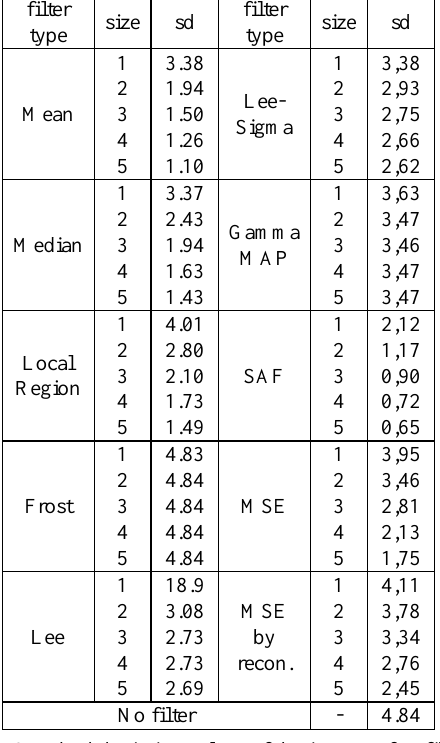
Table 4. Standard deviation values of the images after filtration using selected filters The second fragment of the Radarsat-2 image shows a detailed edges. (Figure 8f) and Median filters (Figure 8b), demonstrate rather poor efficiency: the details are mostly removed from the